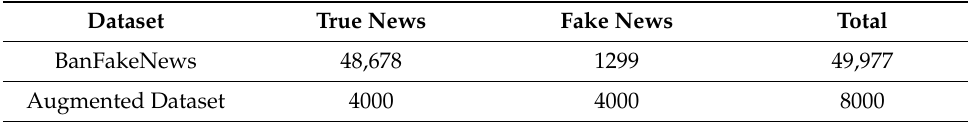
Table 1. Description of the datasets.